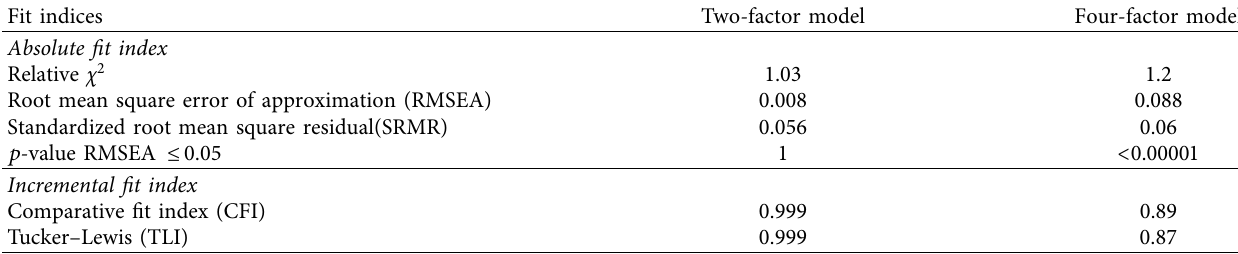
Table 8: Absolute and comparative fit indices for the two- and four-factor CFA